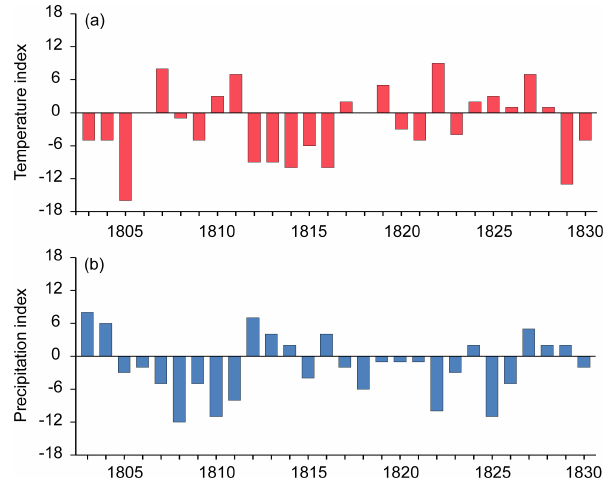
Figure 5. Fluctuations in annual temperature (a) and precipita- tion (b) indices at Buchlovice during 1803–1830 as derived from the weather diary kept by Šimon Hausner.